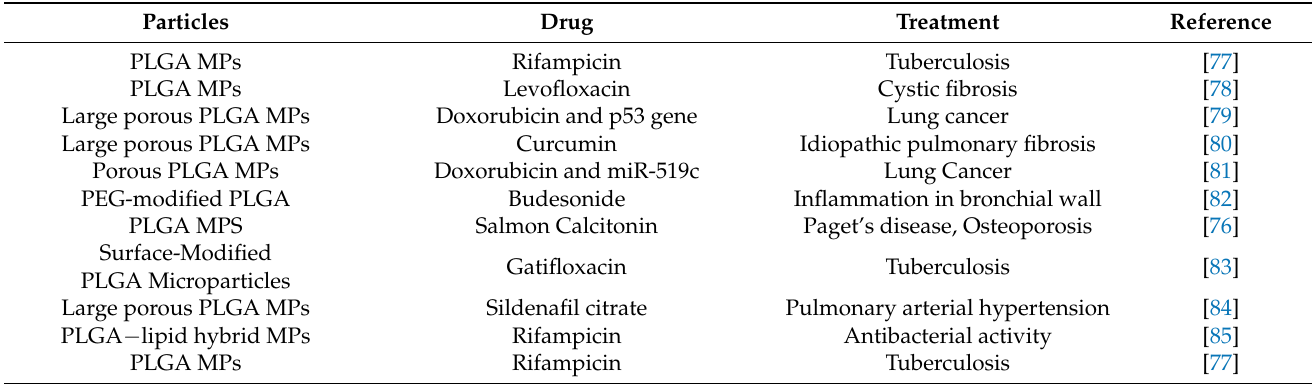
Table 2. Inhalable PLGA microparticles for pulmonary drug delivery